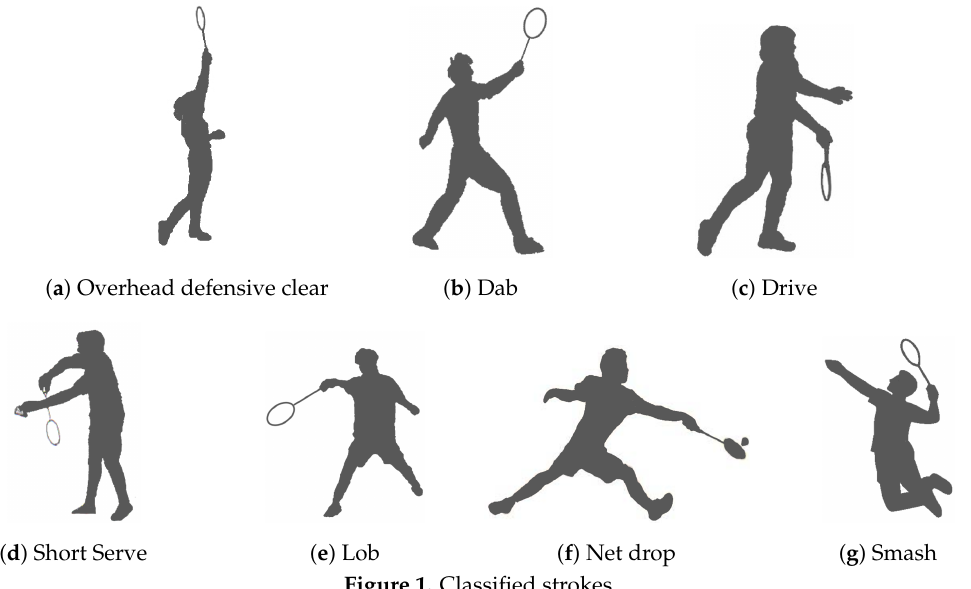
Figure 1. Classified